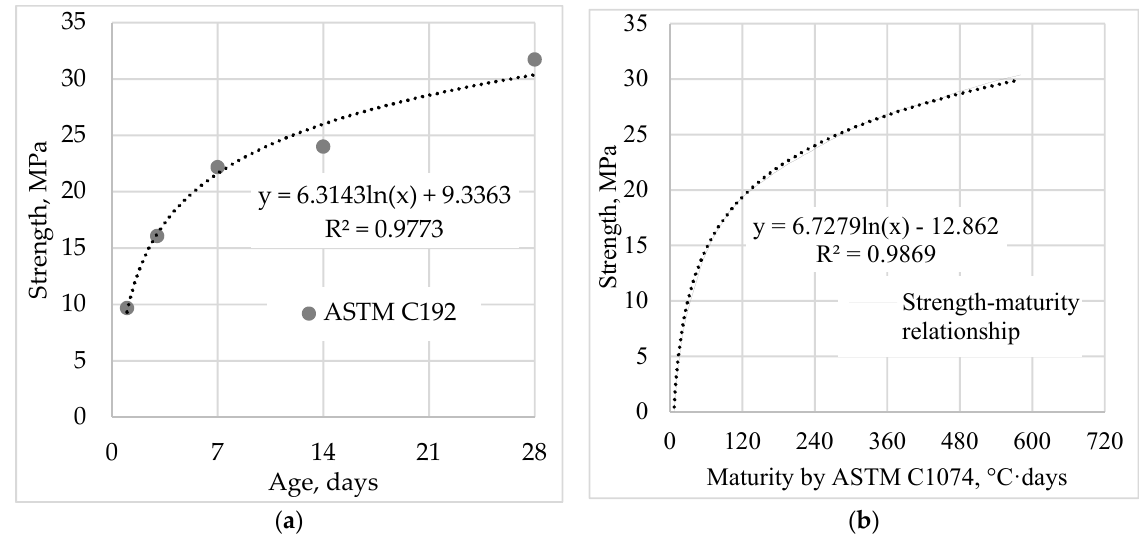
Figure 6. Concrete strength gained over time: ( a ) Compressive strength on the 1st, 3rd, 7th, 14th and 28th days; ( b ) Maturity–strength relationship according to [13].